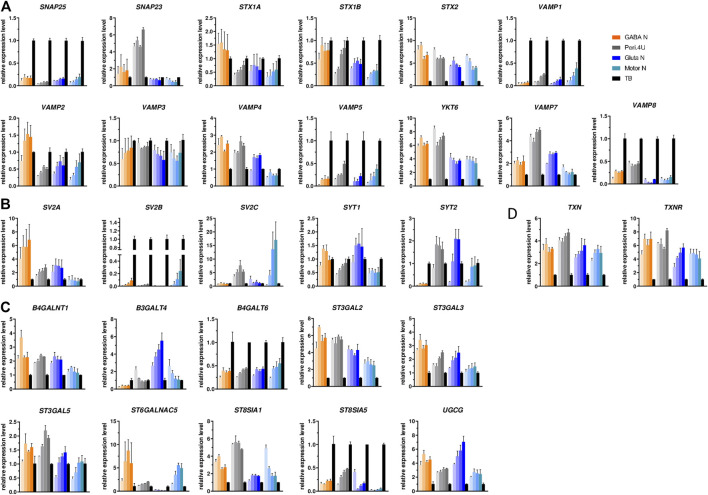
Expression of the different BoNT SNARE substrates, BoNT receptors and gangliosides. (A–C) Time-course gene expression analysis of various SNARE proteins (A), BoNT proteic receptors (B) and enzymes involved in the biosynthesis of gangliosides (C) for the 4 models. For every model, each shade bar represents a different time point: 1 day, 7 days, 14 days and 28 days after thawing; 1 day being the lighter shade. Expression is normalized to GAPDH and to a control cDNA (human total brain: TB).